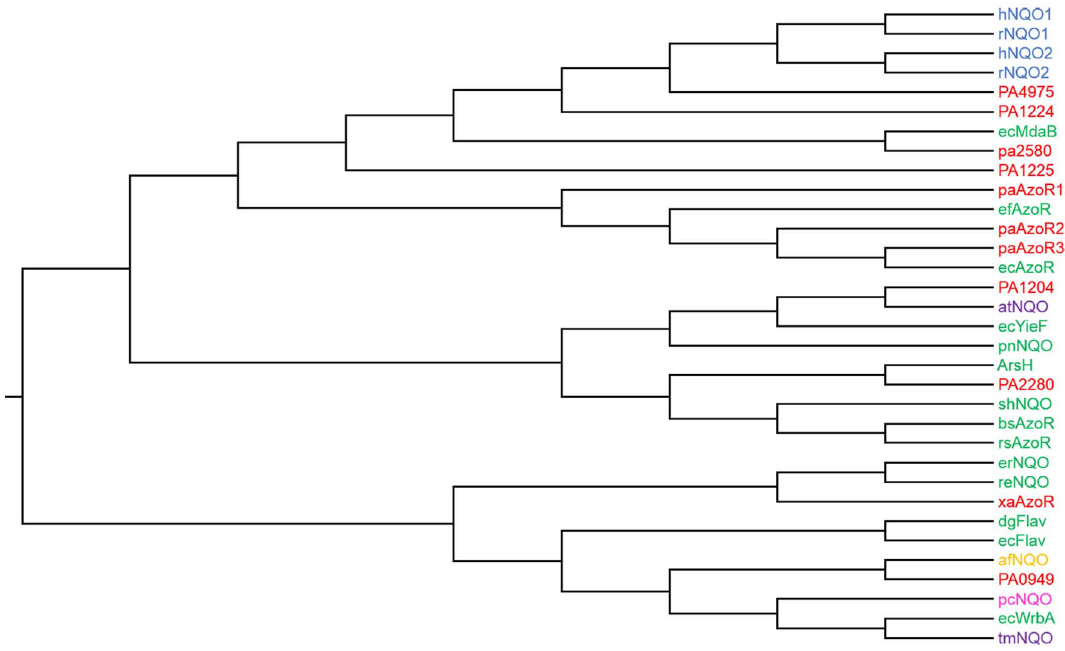
Figure 1. Phylogenetic tree illustrating relationships between known and suspected azoreductases from P.aeruginosa PAO1. An unrooted bootstrap consensus maximum parsimony tree was generated using 500 replicates in Mega 6 [78]. This tree was based upon a sequence alignment of 33 proteins using Muscle [79]. The tree was then rooted so that it is consistent with three previously published trees [74,80,81]. Enzymes in red are from P. aeruginosa , those in green are other bacterial enzymes, those in blue are mammalian enzymes, those in purple are plant enzymes, those in pink are fungal enzymes and those in yellow are archeal. PA0949, PA1204, PA1224, PA1225, PA2280, PA2580, and PA4975 are proteins from P. aeruginosa . ecAzoR, bsAzoR, efAzoR and rsAzoR are azoreductases from E. coli , Bacillus subtilis , Enterococcus faecalus and Rhodobacter sphaeroides . hNQO1 hNQO2, rNQO1 and rNQO2 are human and rat azoreductases. xaAzoR is a flavin independent azoreductase from X. azovorans . ecMdaB, ecYieF and ecWrbA are NAD(P)H quinone oxidoreductases from E. coli . afNQO, pnNQO, tmNQO, pcNQO and atNQO are NAD(P)H quinone oxidoreductases from Archaeoglobus fulgidus , Paracoccus denitrificans , Triticum monococcum , Phanerochaete chrysosporium and Arabidopsis thaliana respectively. ArsH is an azoreductase from Sinorhizobium meliloti . dgFlav and ecFlav are flavodoxins from Desulfovibrio gigas and E. coli respectively. shNQO, reNQO and erNQO are uncharacterised proteins from Staphylococcus haemolyticus , Ralstonia eutropha and Erwinia chrysanthemi.